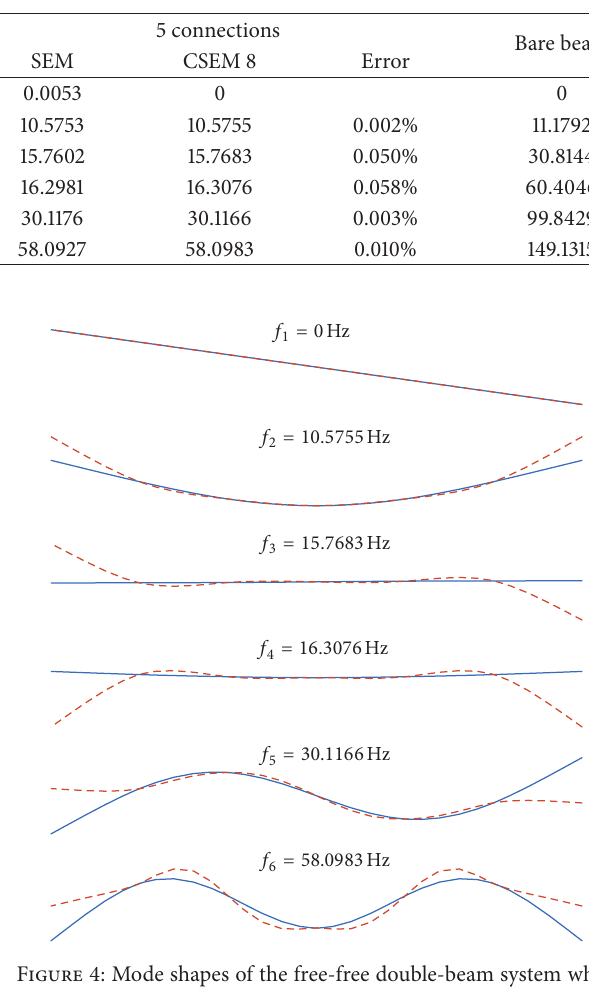
Table 2: Natural frequencies (Hz) of the double-beam system.